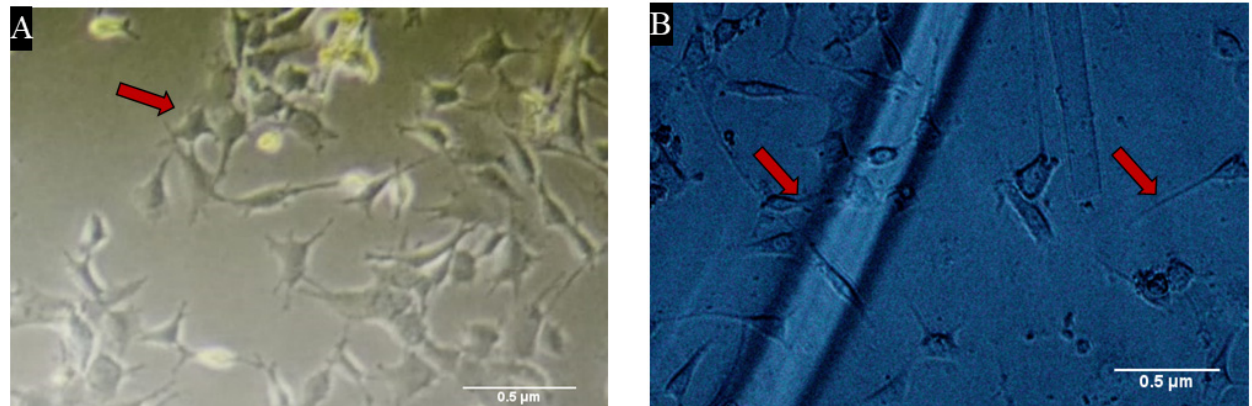
Figure 3. Antibacterial activity of alginate and heparin loaded alginate hydrogels by agar diffusion method: Zones of inhibition of hydrogels against E. coli ( A ) and Staph. aureus ( B ).